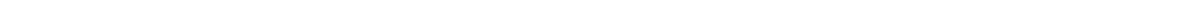
Figure 6 | Hepatic over-expression of TAp63 a causes steatosis via ER stress. ( a ) p63 protein levels in the liver of mice after a tail vein injection of an AAV8 over-expressing either GFP or TAp63 a isoform. ( b ) Representative photomicrographs of hematoxylin-eosin (upper panel) and oil red O staining (lower panel) of mice liver sections ( n ¼ 4 per group); ( c ) total liver TG content, serum AST, ALTand TG levels ( n ¼ 9 AAV8-GFP and 10 AAV8-TAp63 a ); ( d ) protein levels of FAS, pJNK/JNK, pIRE/IRE, XBP1s, pPERK, peIF2 a /eIF2 a , cleaved caspase 3, cleaved caspase 7, ApoB100 and ApoB48; and ( e ) mRNA expression of CPT1, ACADM, ACADL and FATP2 in the liver of mice after hepatic over-expression of TAp63 and IP TUDCA administration ( n ¼ 7 per group). ( f ) GRP78 protein levels in the liver of mice after a tail vein injection of an Ad over-expressing either GFP or GRP78 ( n ¼ 6 per group). ( g ) Representative photomicrographs of hematoxylin-eosin (upper panel) and oil red O staining (lower panel) of mice liver sections ( n ¼ 4 per group); ( h ) total liver TG content, serum AST, TG and ketone bodies levels ( n ¼ 9 AAV8-GFP and 10 AAV8-TAp63 a ); ( i ) protein levels of FAS, pIRE/IRE, XBP1s, ApoB100 and ApoB48 ( n ¼ 6 per group); and ( j ) mRNA expression of CPT1, ACADM, ACADL and FATP2 in the liver of mice after hepatic over-expression of TAp63 a and Ad GRP78 administration ( n ¼ 8 per group). Protein GAPDH or transferrin levels were used to normalize protein levels and control values (AAV8 GFP) were normalized to 100%. Dividing lines indicate splicings in the same gel ( n ¼ 7 per group). Uncropped blots of this Figure accompanied by the location of molecular weight markers are shown in Supplementary Fig. 15 and Supplementary Fig. 16. Data are presented as mean ± standard error mean (s.e.m.). Statistical significance, * P o 0.05, ** P o 0.01 and *** P o 0.001. For multiple comparison ( c – e , h – j ) a one way ANOVA followed by Bonferroni or Kruskal-Wallis test was performed. Student t -test was used in TAp63alpha and GRP78 liver protein levels ( a , f